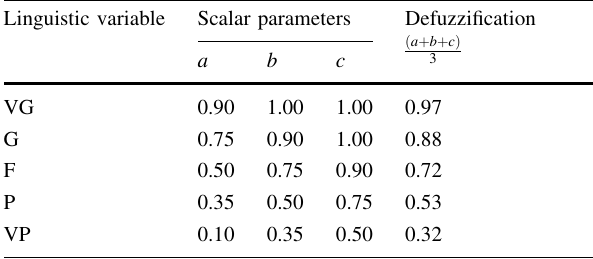
Table 8 Scalar parameters of linguistic variables Linguistic variable Scalar parameters